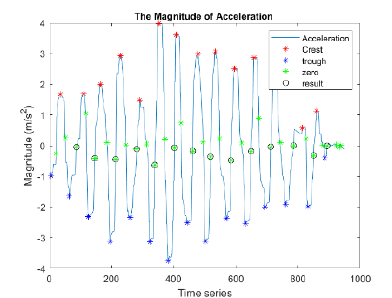
Figure 6. The illustration of step detection